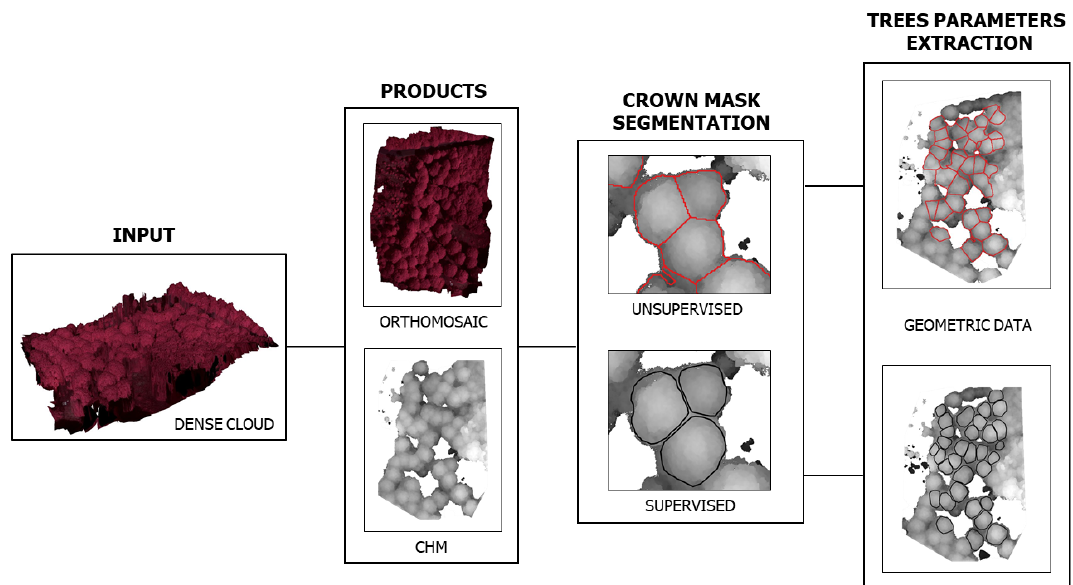
Figure 2. UAV elaboration data workflow.